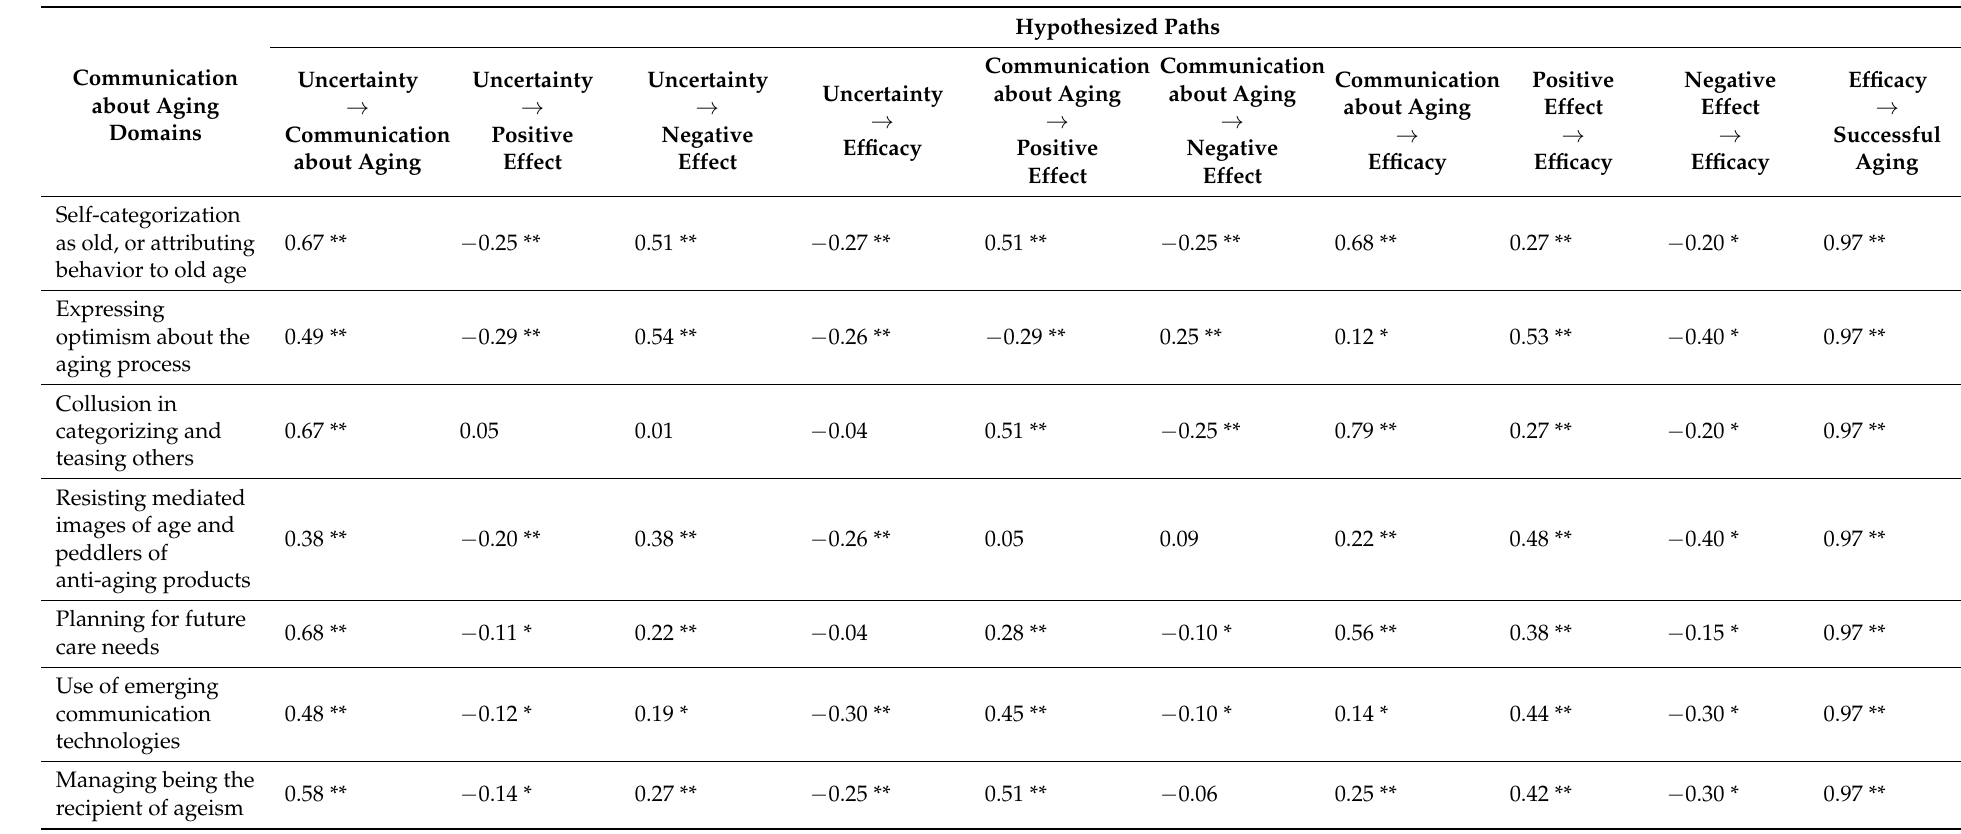
Table A5. Standardized regression coefficients for communication ecology